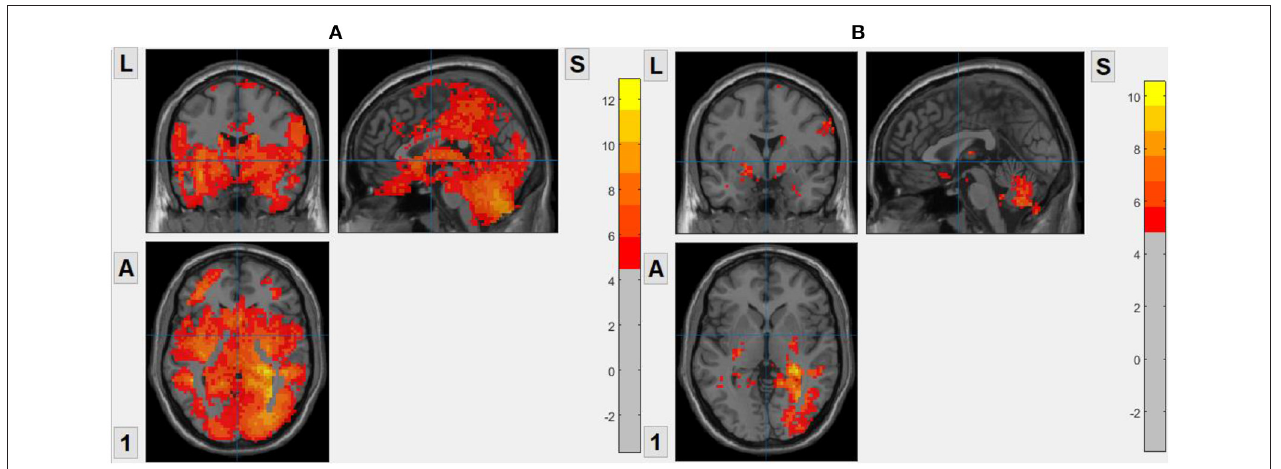
FIGURE 2 | Brain regions with statistical differences between OCD and HC. Warm color means OCD has a higher value. (A) ApEn, based on voxel, m = 2, r = 0.2. (B) FuzzyEn, based on voxel, m = 2, r =